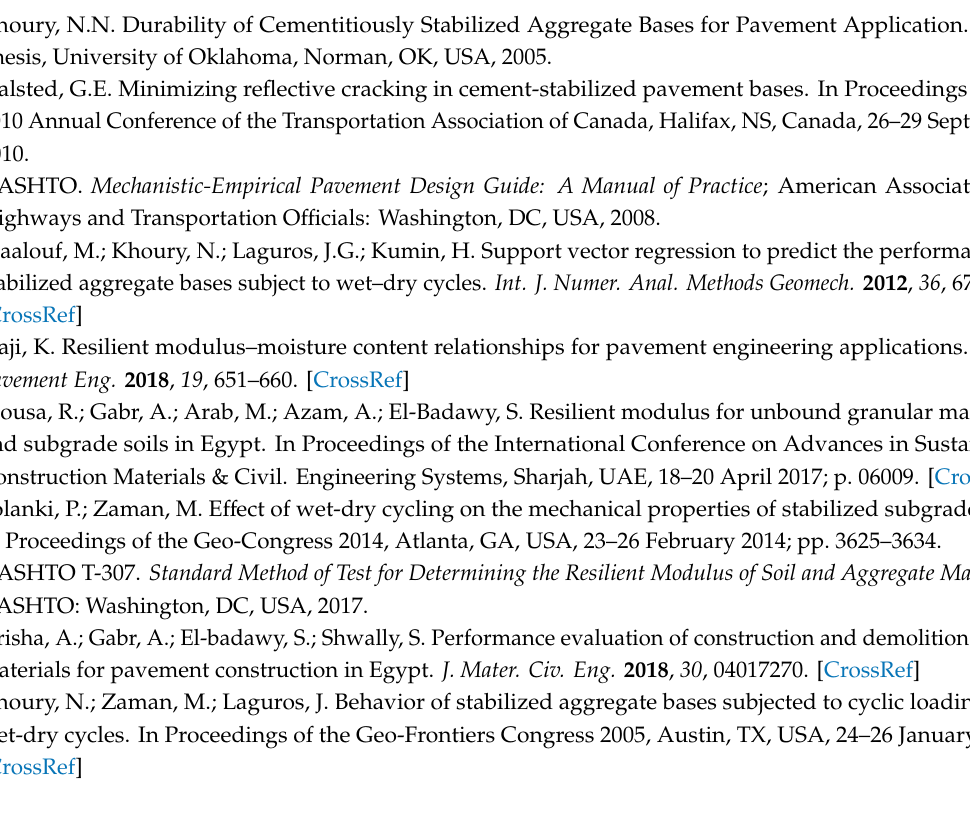
Table S1: Training data; Table S2: Test